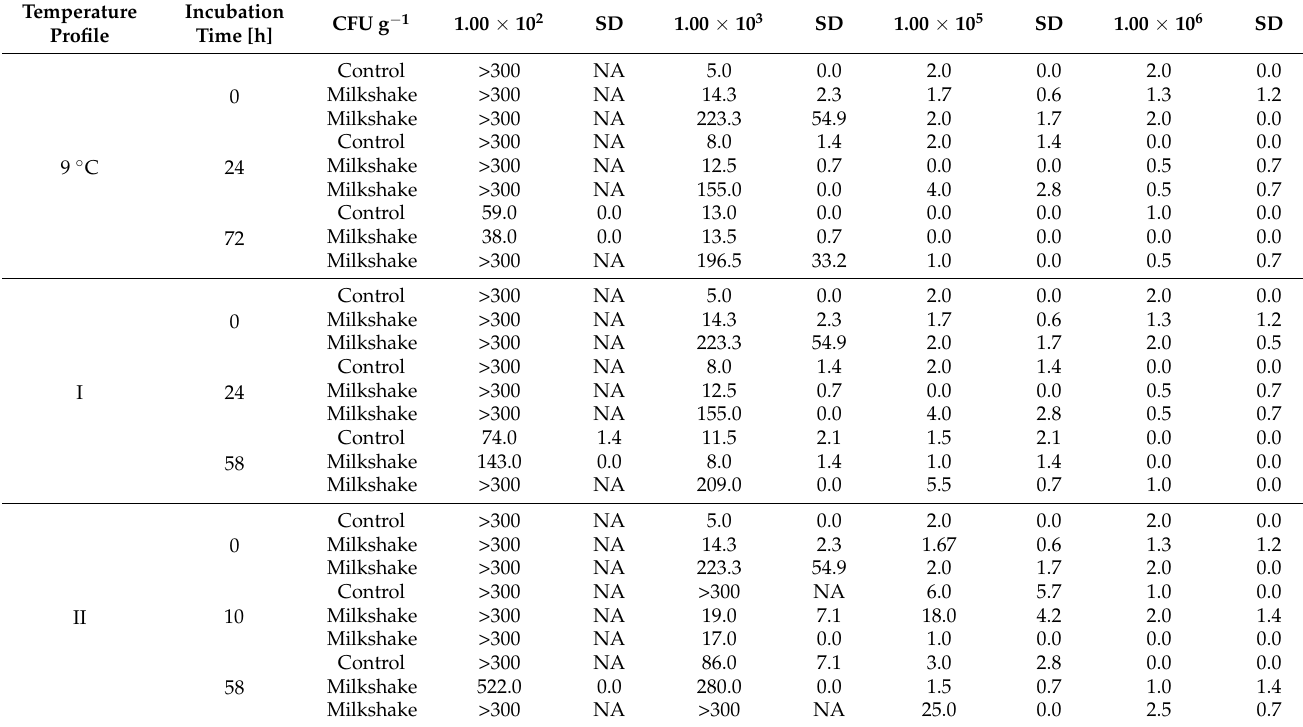
Table A2. The average count of B. subtilis from growth experiments in different temperature profiles in goji berry